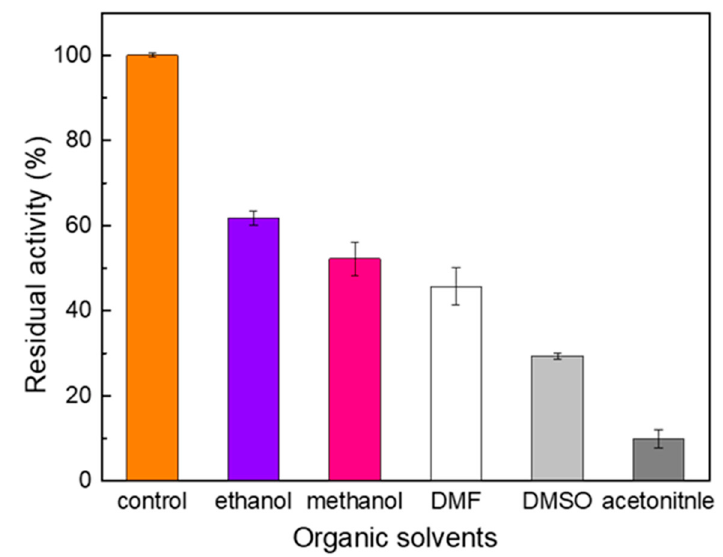
Figure 6. Activity of Melac13220 after 1 h of pre-incubation in the presence of organic solvents at 10% ( v / v ) concentration. The enzyme activity in the absence of organic solvents was regarded as 100%. Values represent the mean ± standard deviation of three measurements.